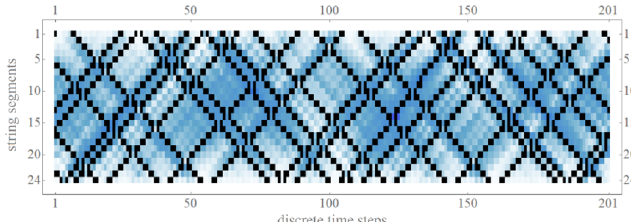
Figure 21 . Density plot of the deficit angle on the worldsheet. The horizontal axis labels elemen- tary time steps. The parameters of the simulation are ∆ t = 8 , (cid:15) = 0 . 1 , N time steps (not shown). The figure corresponds to the last two columns in figure